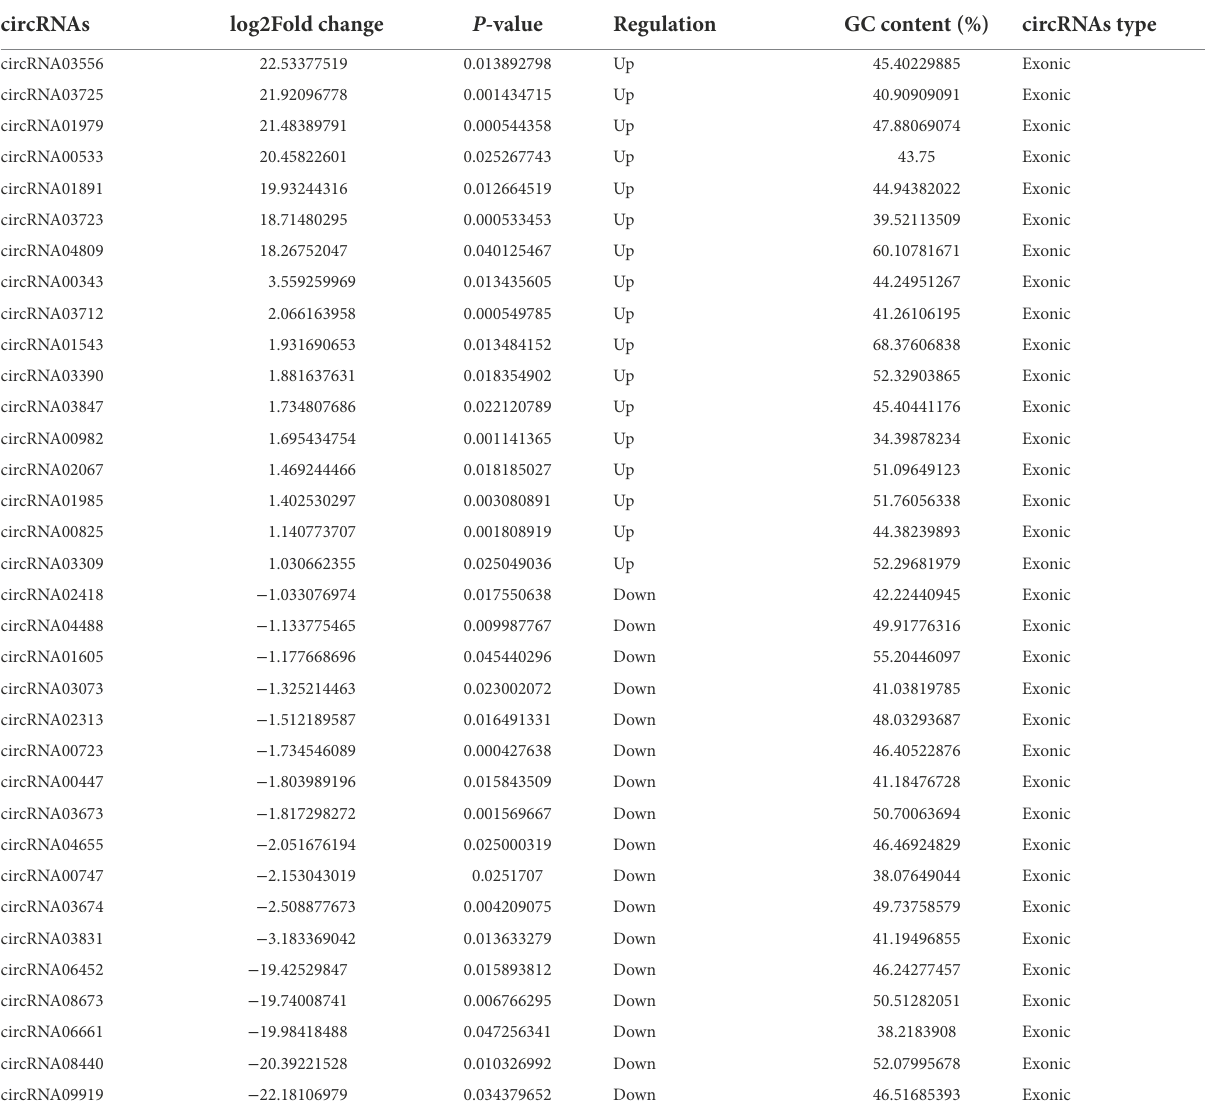
TABLE 2 Information of differentially expressed